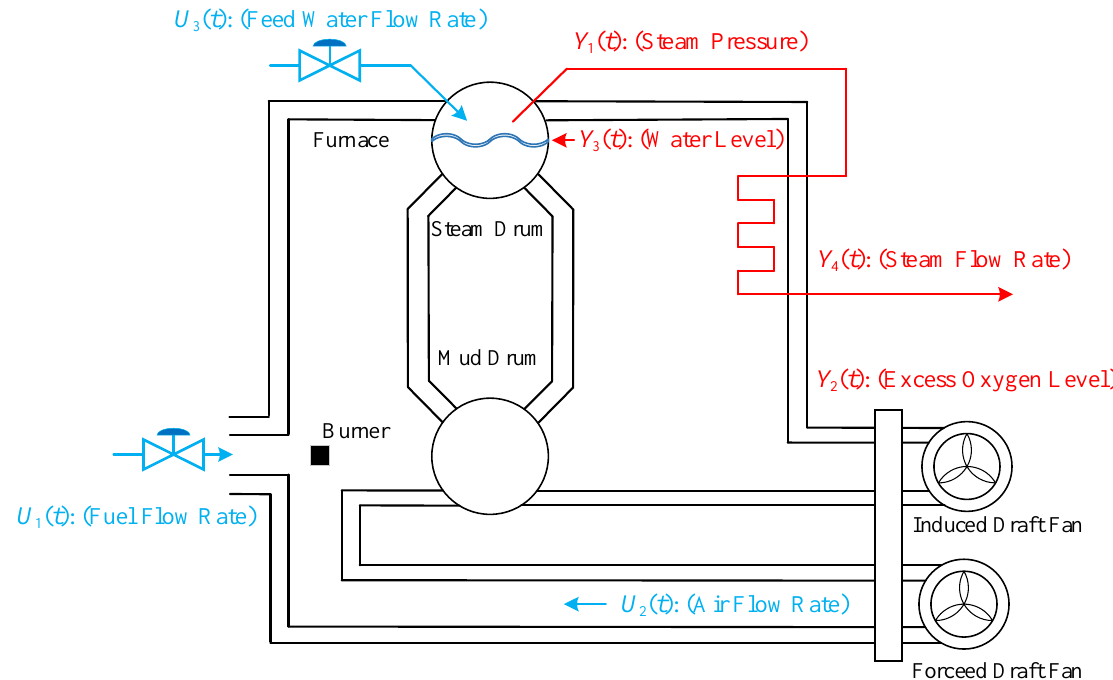
Figure 1. Configuration of nonlinear boiler system.